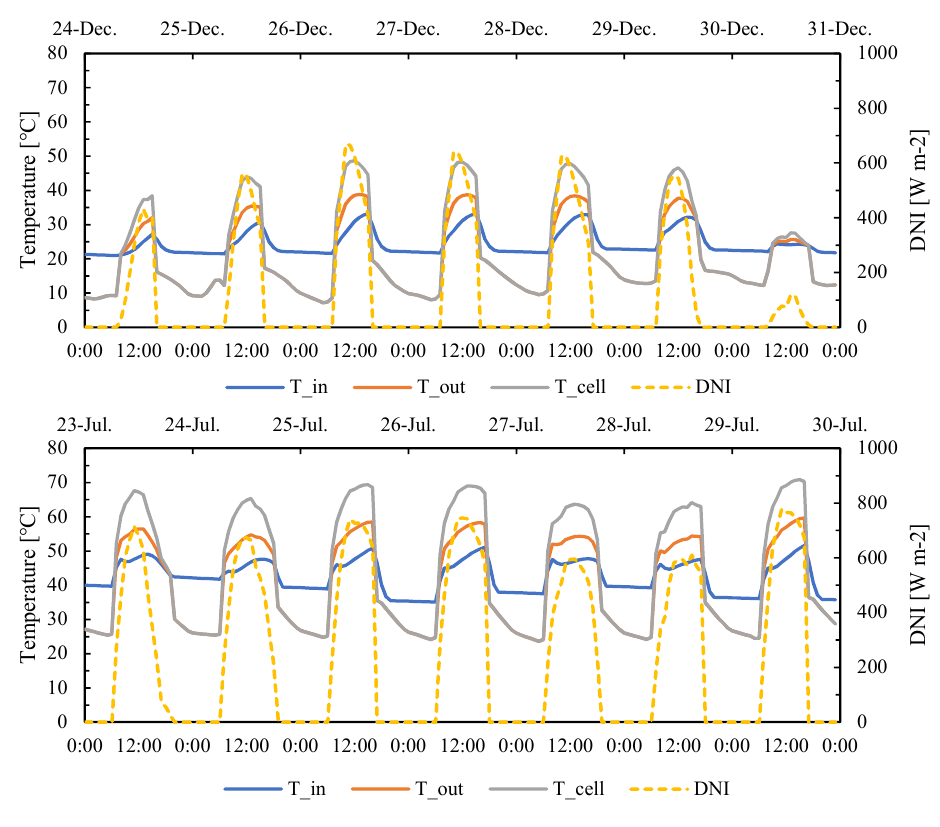
Figure 4. Temperature profile of the LCPV / T plant and DNI during the typical weeks of winter ( top ) and summer ( bottom ) (Source: Author own calculation).